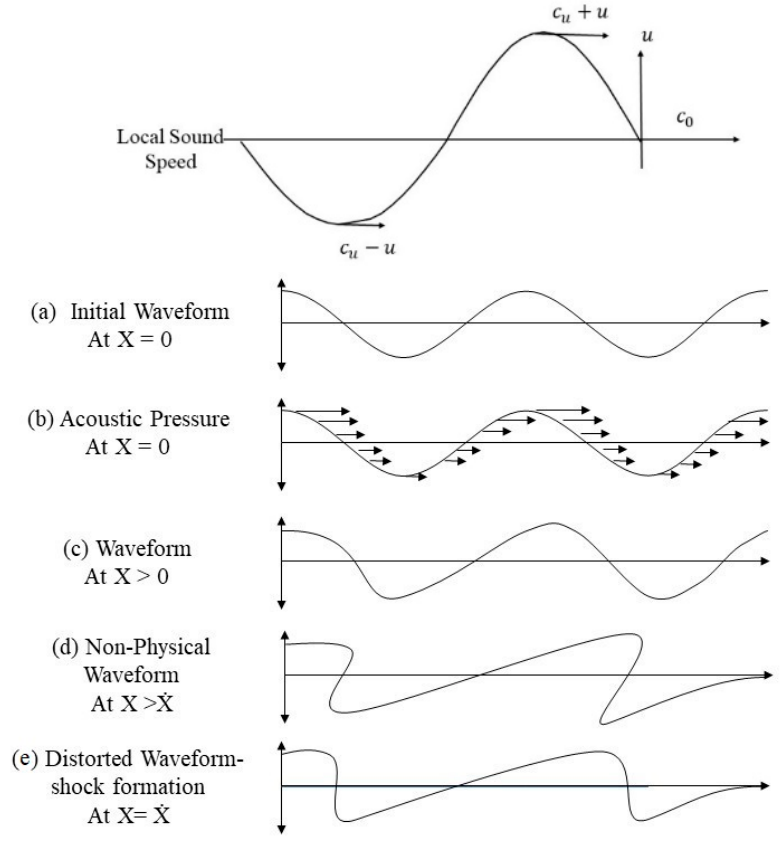
Figure 2. Schematic representation of acoustic distortion and shock formation during nonlinear propagation [Adopted based on figures in Blackstock and Hamilton (1998) and Leighton (2007)].